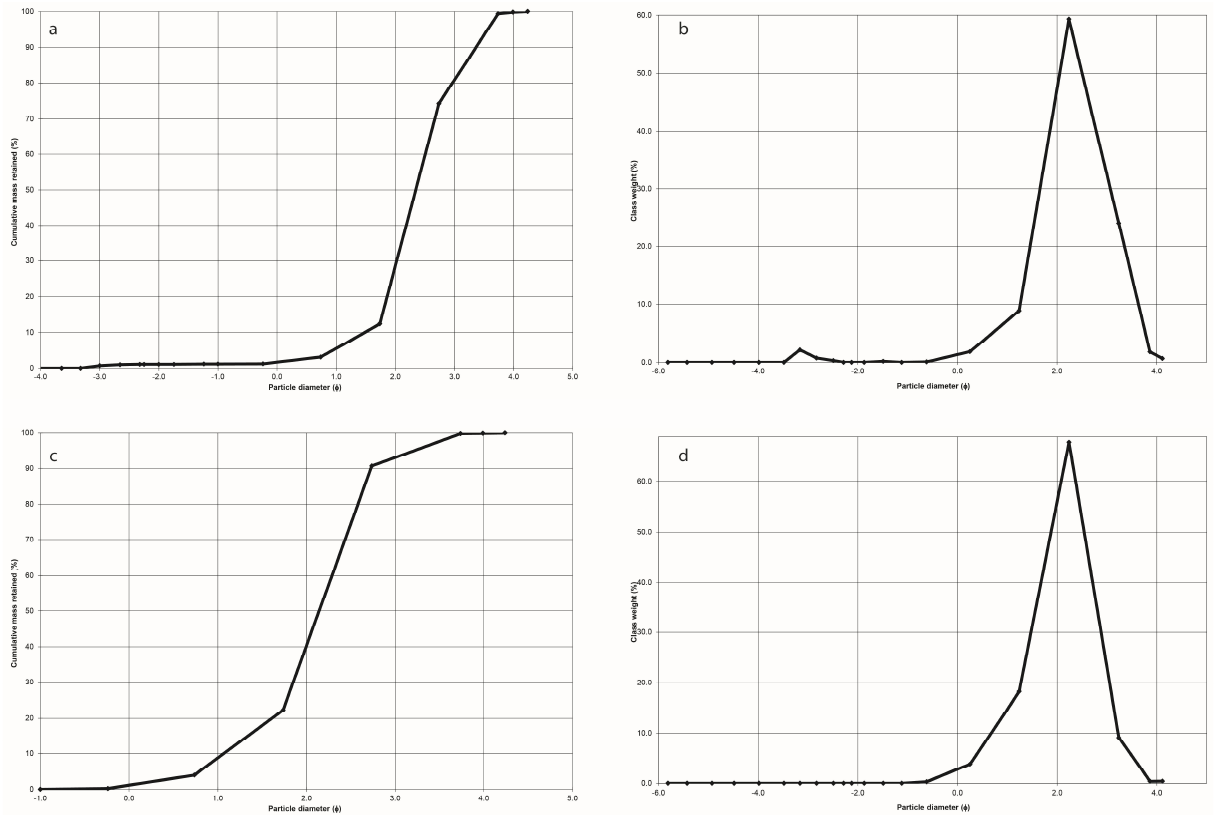
Figure 5. Cumulative (phi) and Distribution (phi) curves. ( a , b ) sample AK5/SD. ( c , d ) sample